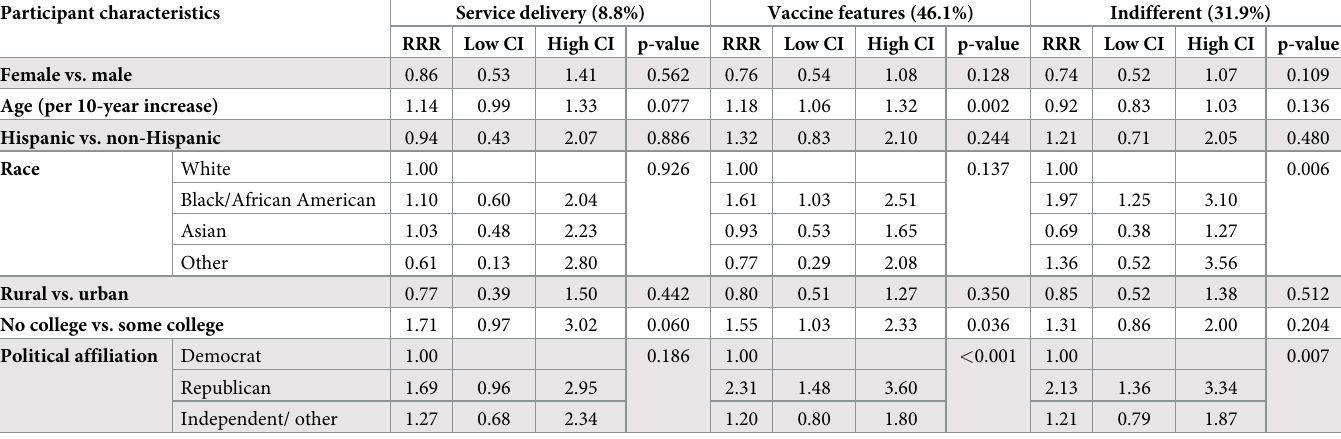
Table 3. Weighted multinomial logit model: Predictors of latent class membership for “service features”, “vaccine features” and “indifferent” preference groups rel- ative to the “social proof” preference group (13.2%). Participant characteristics